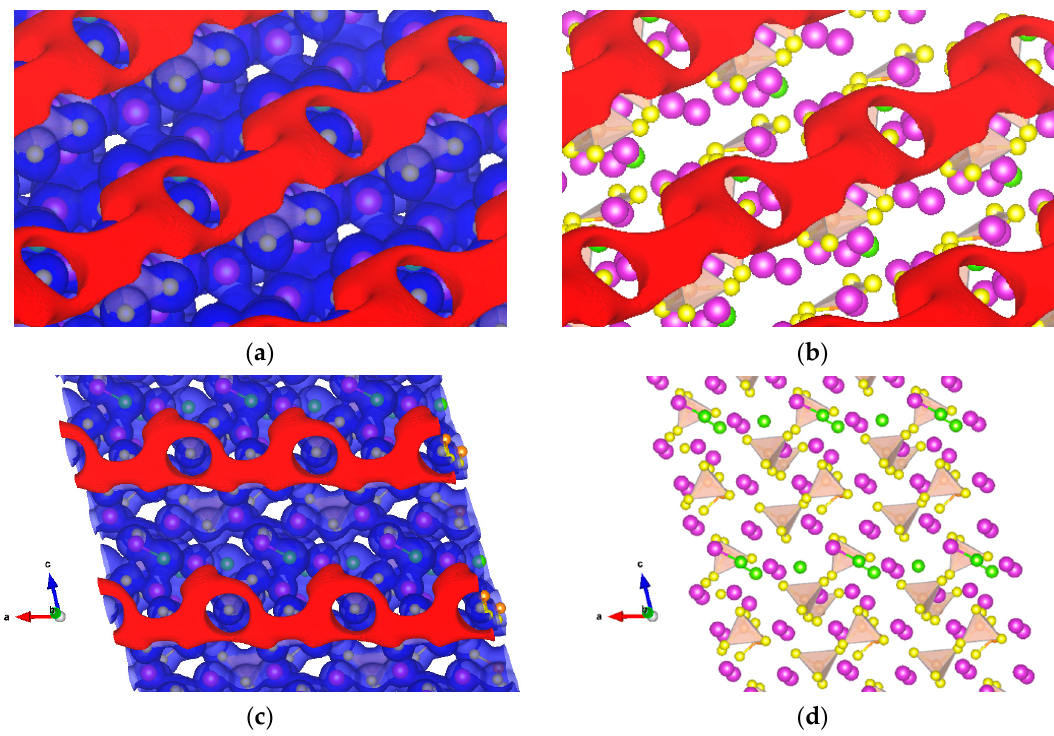
Figure 11. Isopotential surfaces of solid electrolyte Li 7 P 2 S 8 I, separated between negative (red) and positive (blue) regions. ( a ) Shows the +0.5 and − 3.8 V isosurfaces along the b-axis perpendicular to the crystal surface; ( b ) atomic conformation with the negative isopotential; ( c ) front view of the isopotential surfaces along b-axis; and ( d ) atomic conformation front view. Solid purple spheres represent lithium, green for iodine, yellow for sulfur, and orange for the PS 4 tetrahedron.